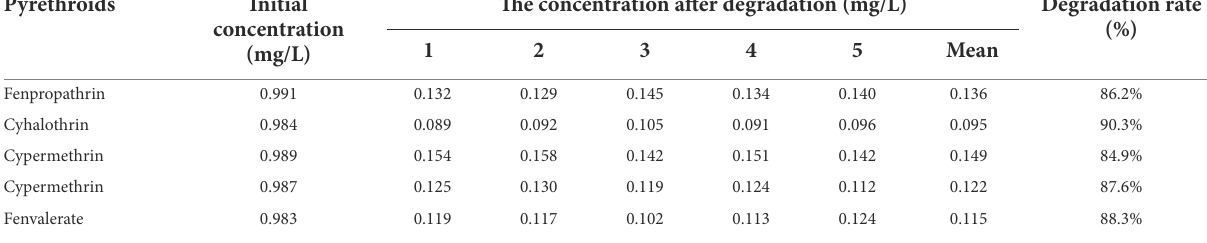
TABLE 2 Degradation rate of five pyrethroids by Est882. Pyrethroids